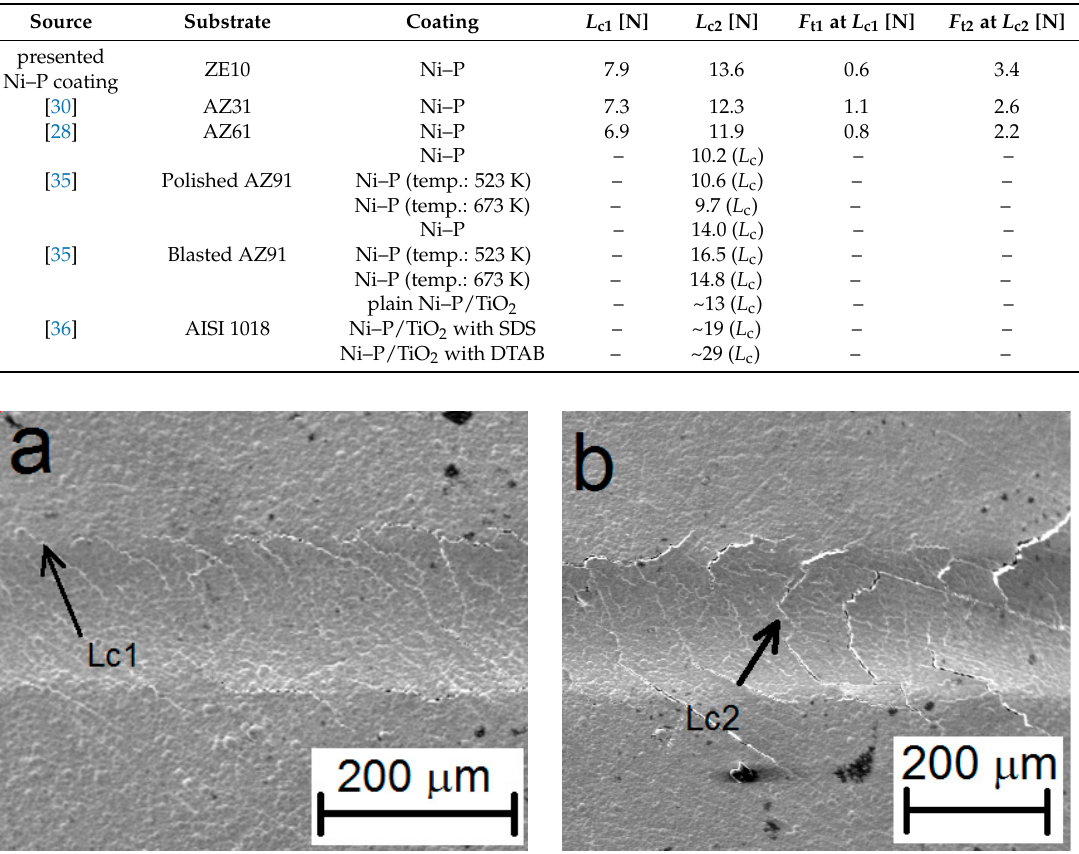
Figure 5. Detail of the damage of Ni–P coating during the scratch test: ( a ) L c1 and ( b ) L c2 (SEM).